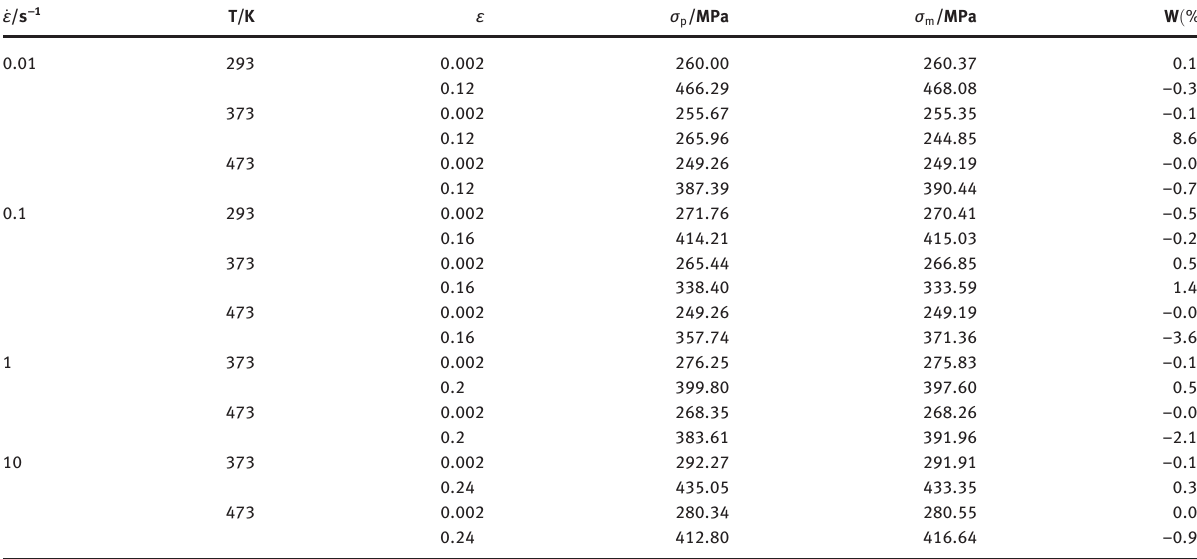
Figure 18: Comparisons between pre- dicted and measured of BR1500HS alloy under low deformation temperature region with strain rates of (a) 293K; (b) 373K; (c) 473K.